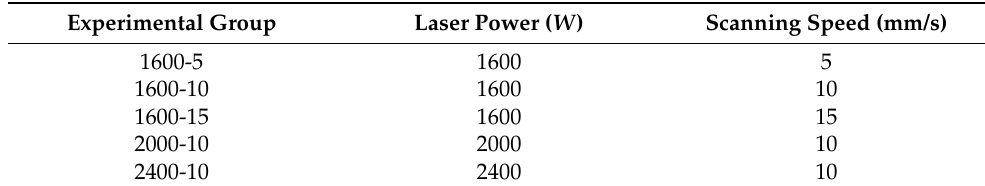
Table 2. Parameters for studying the effect of the laser cladding coating.